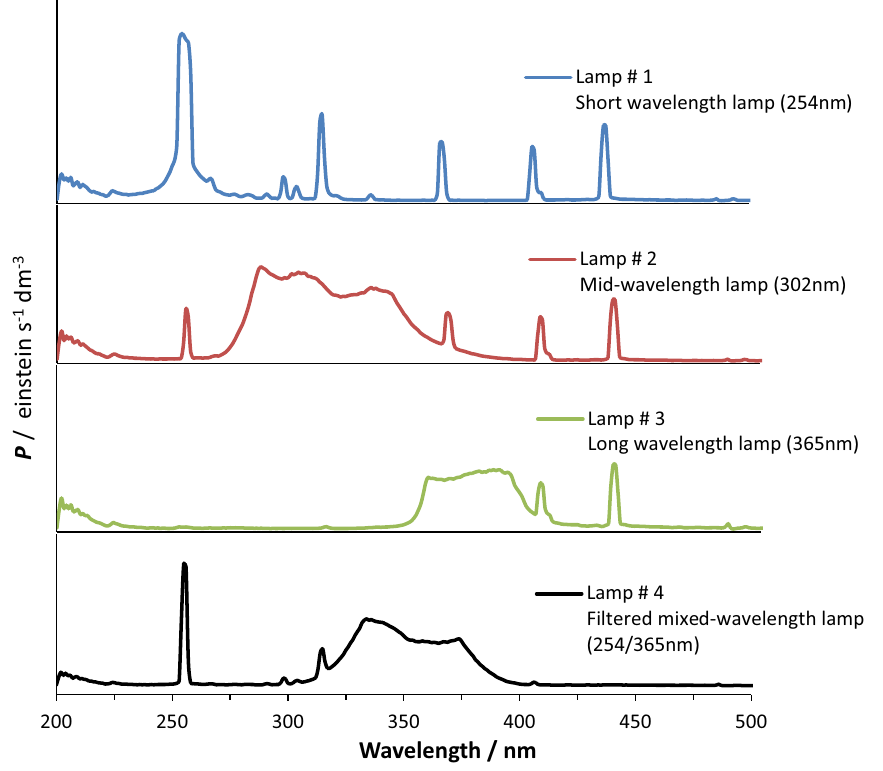
Figure 1. Light profiles of the different light sources used in this study. The profiles were measured on an Avantes